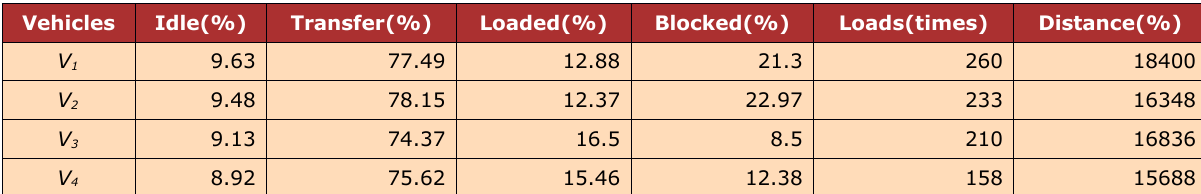
Table 3. The simulation results of vehicles on initial